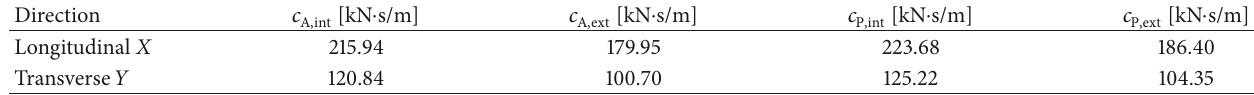
Table 6: Values of the damping constants of the substructure elements.